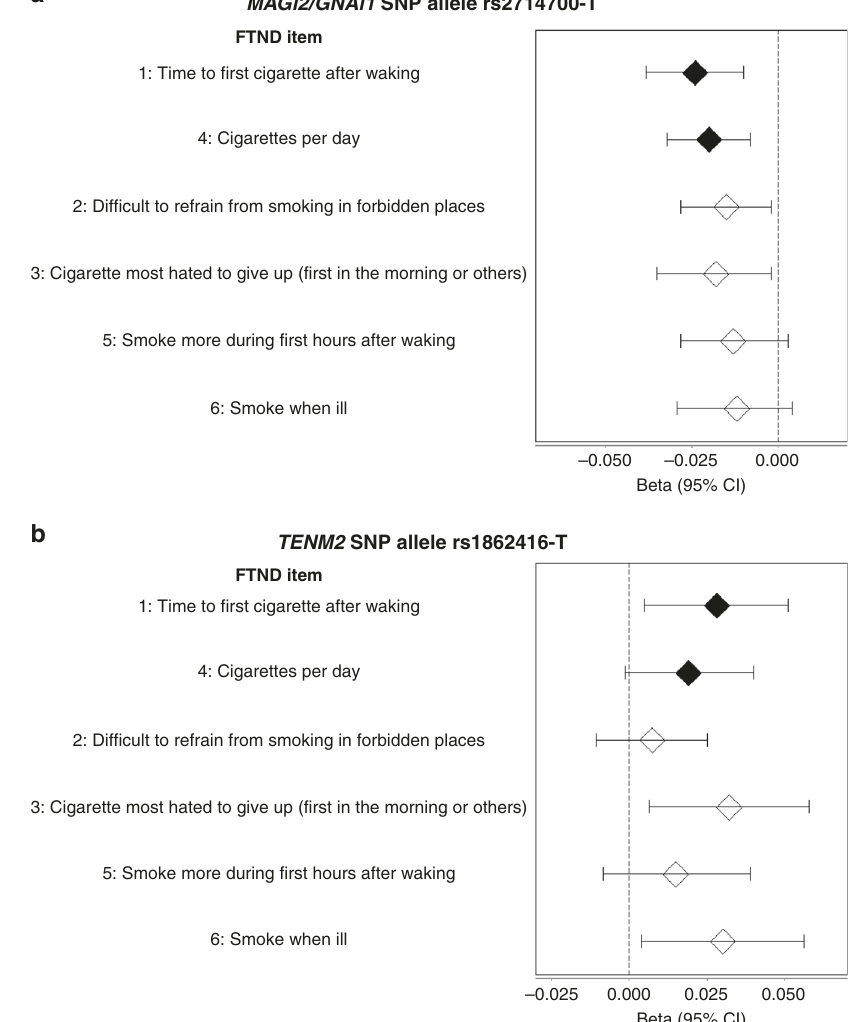
Fig. 2 Single nucleotide polymorphism (SNP) associations with speci fi c Fagerström Test for Nicotine Dependence (FTND) items. Beta values and corresponding 95% con fi dence intervals (CIs) were taken from cross-ancestry meta-analysis of a rs2714700 and b rs1862416 using linear regression models for categorical FTND item responses (1 and 4, closed diamonds) or logistic regression models for binary FTND item responses (2, 3, 5, and 6, open diamonds) across the iNDiGO studies (N up to 47,569 biologically independent samples with complete FTND data contributing to the speci fi c item analyses). Diamonds indicate the beta values, and error bars correspond to the 95% CI estimates for the beta